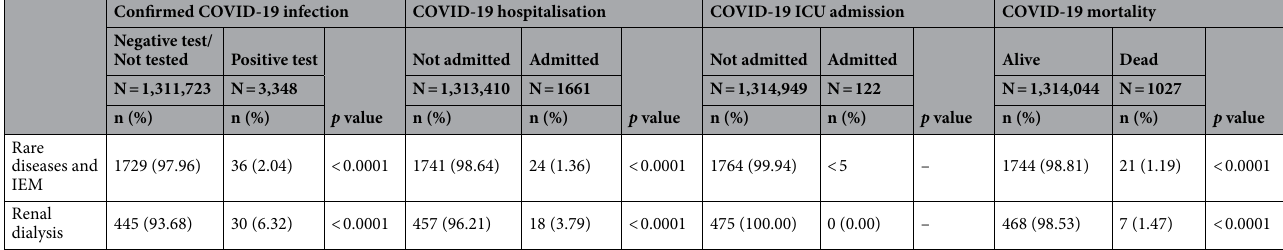
Table 2. Crude, population-level COVID-19 outcomes by sociodemographic characteristics, risk category and risk criteria. N number; IEM inborn errors of metabolism.